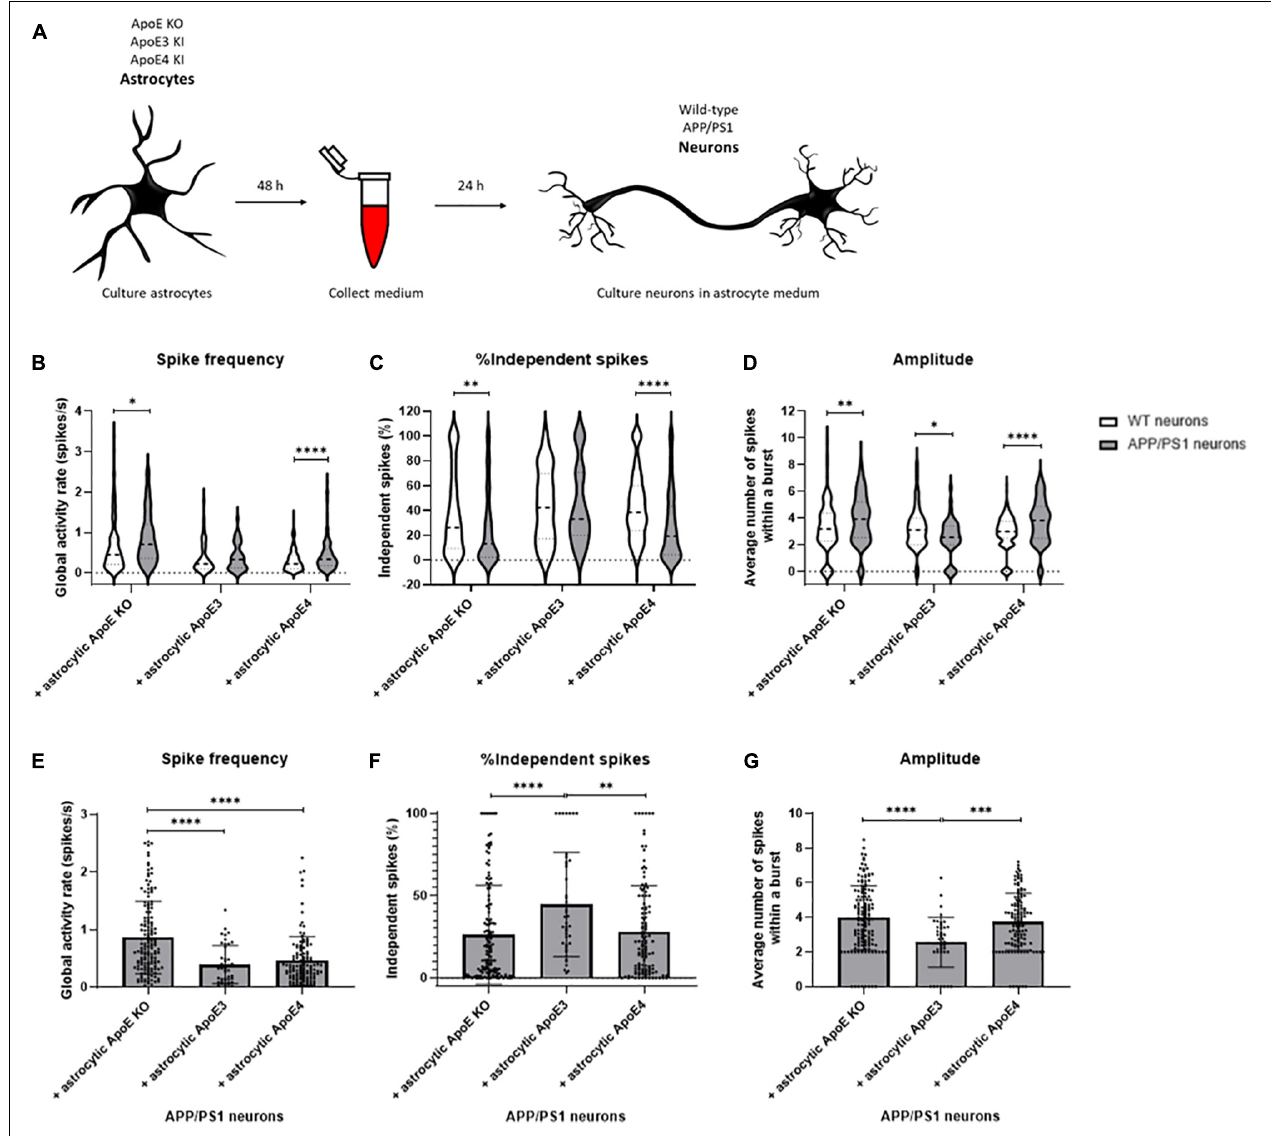
FIGURE 6 | Neuronal activity is increased in APP/PS1 AD transgenic compared to wild-type neurons cultured in ApoE KO and ApoE4 astrocyte medium but not ApoE3 astrocyte medium. (A) Schematic overview of collection of ApoE KO, ApoE3 and ApoE4 astrocyte conditioned medium and subsequent treatment of wild-type and AD transgenic APP/PS1 neurons (18–20 DIV). (B–D) Quantification of spike frequency (B) , percentages of independent spikes per culture (C) , and amplitude (D) in wild-type and APP/PS1 neurons treated with ApoE KO, ApoE3 and ApoE4 astrocyte conditioned medium for 24 h ( N wild − type + ApoEKO = 5 embryos, N wild − type + ApoE 3 = 4 embryos, N wild − type + ApoE 4 = 4 embryos, N APP / PS 1 + ApoEKO = 4 embryos, N APP / PS 1 + ApoE 3 = 4 embryos, N APP / PS 1 + ApoE 4 = 4 embryos; n wild − type + ApoEKO = 119 neurons, n wild − type + ApoE 3 = 48 neurons, n wild − type + ApoE 4 = 171 neurons, n APP / PS 1 + ApoEKO = 148 neurons, n APP / PS 1 + ApoE 3 = 43 neurons, n APP / PS 1 + ApoE 4 = 123 neurons). Data are expressed as violin plots. Statistical differences between wild-type and APP/PS1 neurons with different astrocyte medium conditions were analyzed using multiple t -tests. (E–G) Quantification of spike frequency (E) , percentages of independent spikes within a neuronal culture (F) , and amplitude (G) in APP/PS1 neurons treated with astrocytic ApoE KO, ApoE3 and ApoE4 astrocyte media for 24 h ( N APP / PS 1 + ApoEKO = 4 embryos, N APP / PS 1 + ApoE 3 = 4 embryos, N APP / PS 1 + ApoE 4 = 4 embryos; n APP / PS 1 + ApoEKO = 148 neurons, n APP / PS 1 + ApoE 3 = 43 neurons, n APP / PS 1 + ApoE 4 = 123 neurons). Kruskal Wallis tests in combination with Dunn’s tests were performed to assess statistical differences between the different groups. Data are expressed as mean ± SD. * p < 0.05; ** p < 0.01; *** p < 0.001; **** p <